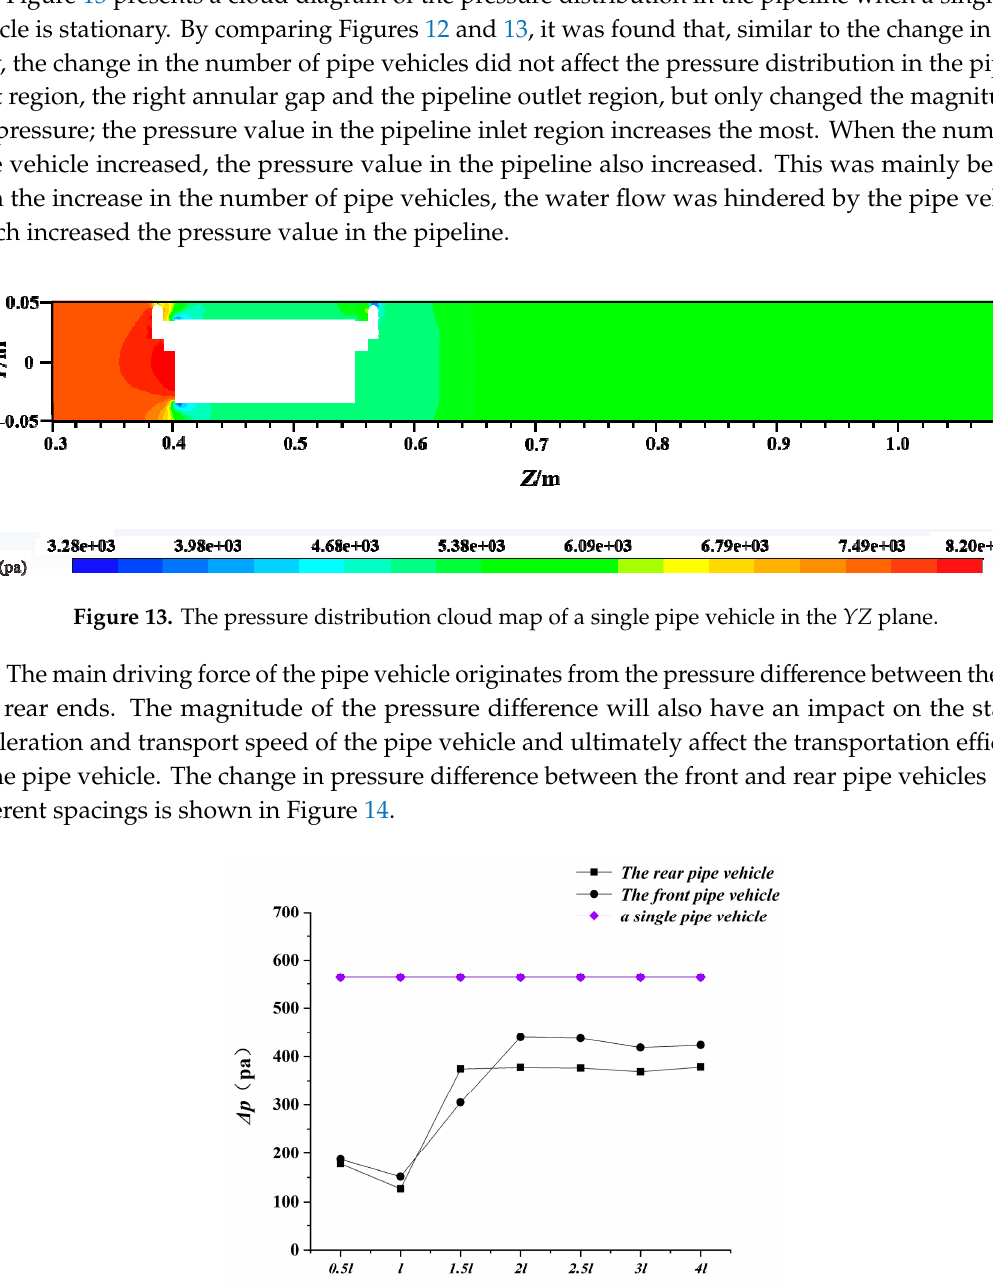
Figure 12. The pressure distribution cloud map of the YZ plane under different vehicle spacings. ( a ) L = 0.5 l . ( b ) L = l . ( c ) L = 1.5 l . ( d ) L = 2 l . ( e ) L = 2.5 l . ( f ) L = 3 l . ( g ) L = 4 l .